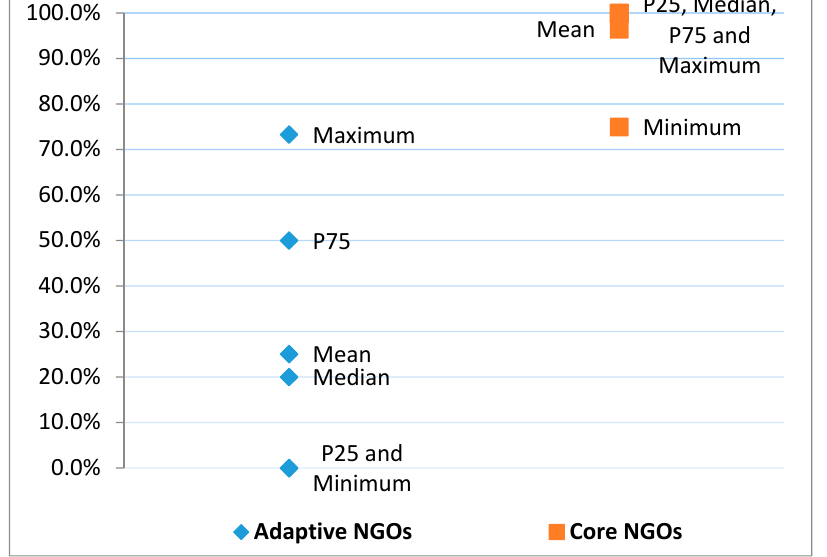
Figure 1. Sensitivity analysis for selection of the 75th percentile for core services as a cutoff for classifying core vs. adaptive NGOs.